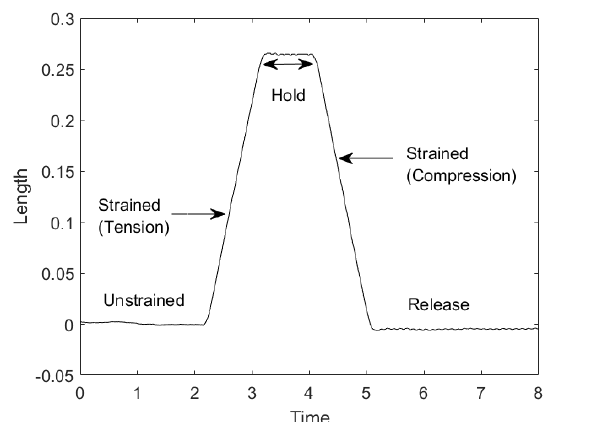
Figure 2. Change in path-length ( ∆ L ) between two given Fibre Bragg Gratings (FBG’s) due to an applied